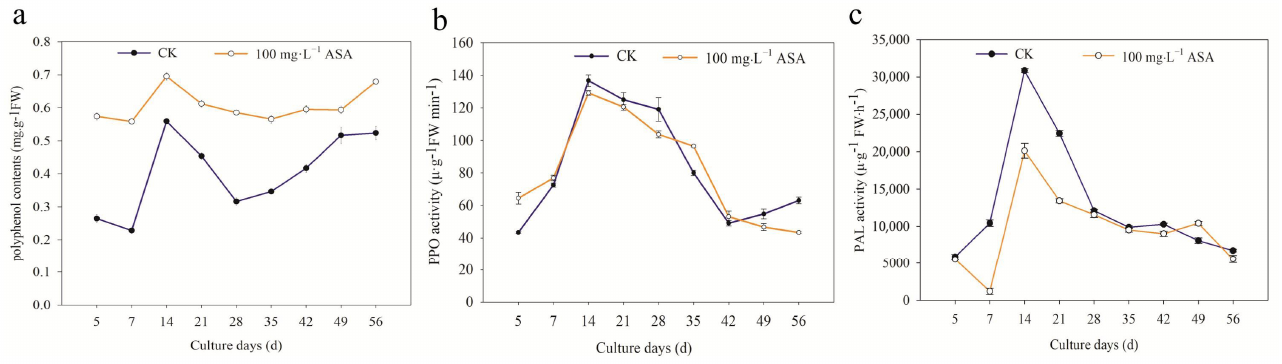
Figure 3. Effects of 0 and 100 mg · L − 1 ASA treatments on polyphenols, PPO activity, and PAL activity during somatic embryogenesis of Fraxinus mandshurica provenance 3. The x -axis represents the culturing days, and the y -axis represents the intracellular polyphenol content ( a ), intracellular PPO activity ( b ), and intracellular PAL activity ( c ). Error bars show the standard error of the mean.